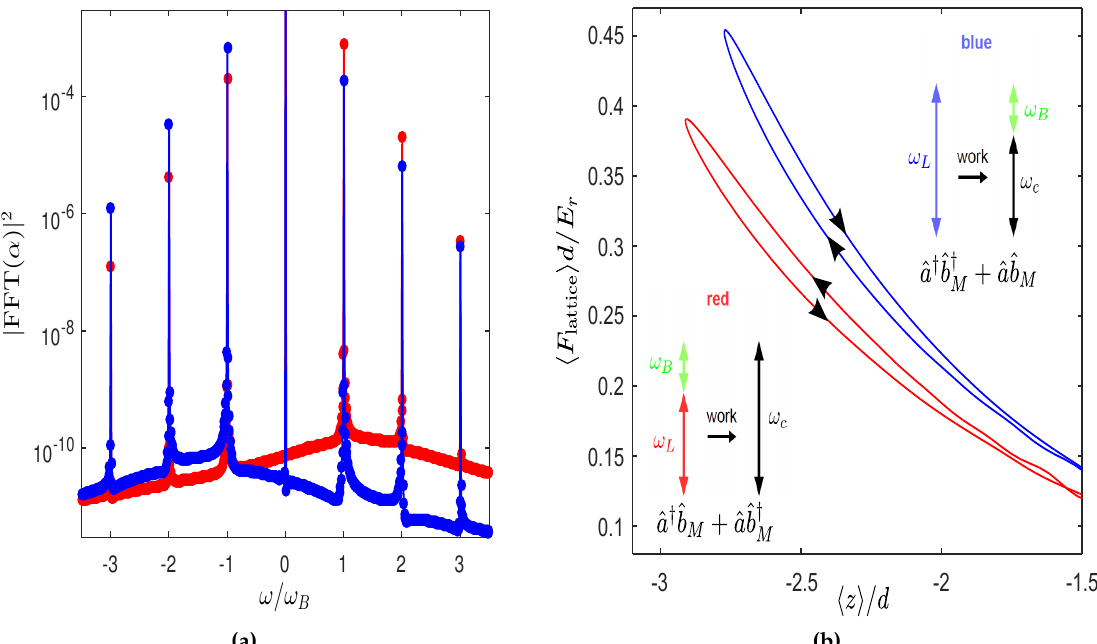
Figure 4. Power spectral density of the cavity field and force-displacement plots for the atomic dynamics. The parameters are the same as in Figure 2a. ( a ) Power spectral density of α ( t ) , obtained by a fast Fourier transform at resolution ω B /100, showing asymmetric sidebands at multiples of ω B with more power in the red upper (blue lower) side band corresponding to downhill (uphill) ± transport in Figure 2a. Note that the frequency origin corresponds to the driving laser frequency, which is different for the red and blue points. ( b ) Average of the force applied by the dynamical intracavity optical lattice as a function of the atomic wave packet centroid position. During uphill (downhill) transport of the atoms, the blue (red) curve is traversed in the clockwise (anti-clockwise) direction, corresponding to positive (negative) work done on the atoms and accounted for by the down-conversion (up-conversion) of the blue-detuned (red-detuned) pump laser photons (see the inset). The insets also show the dominant terms in the effective optomechanical Hamiltonian, which we derive in Section 3, with the operator ˆ b M annihilating a quantum of excitation from the Bloch oscillator. The area enclosed by the loops gives the work done on the atoms by the